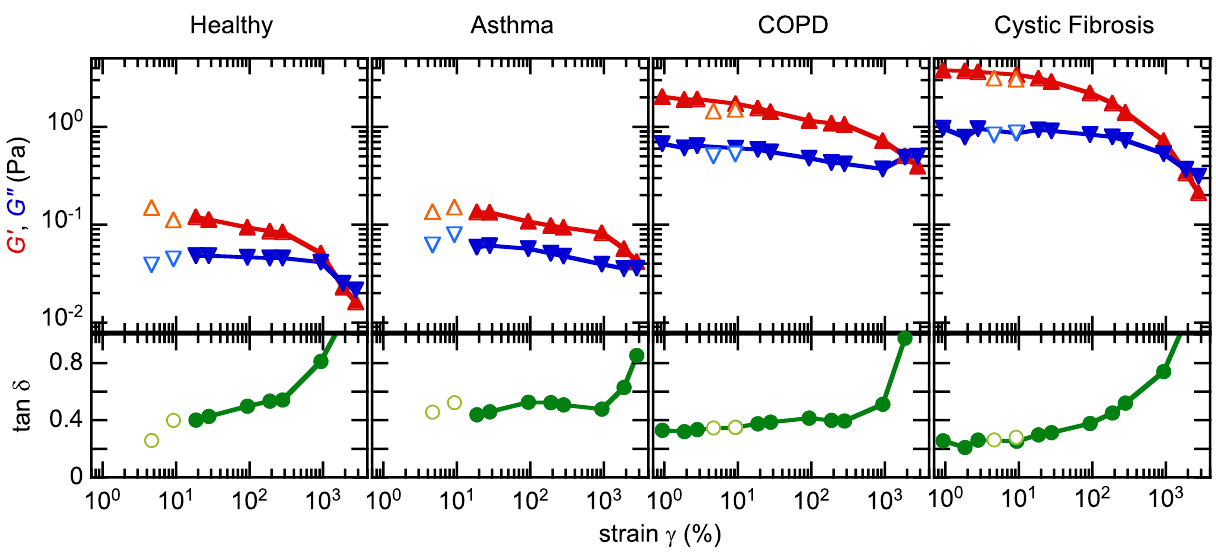
Figure 1. Sputum rheological response to strain. Evolution of the storage ( G ′ , (cid:31) ) and loss ( G ′′ , (cid:31) ) moduli, and G ′ / G ′′ , the damping ratio ( tan δ ) with the applied strain, obtained during a strain sweep in oscillatory mode = • (frequency 0.6 Hz). Open symbols: values obtained in frequency sweeps at 5% and 10% strain,